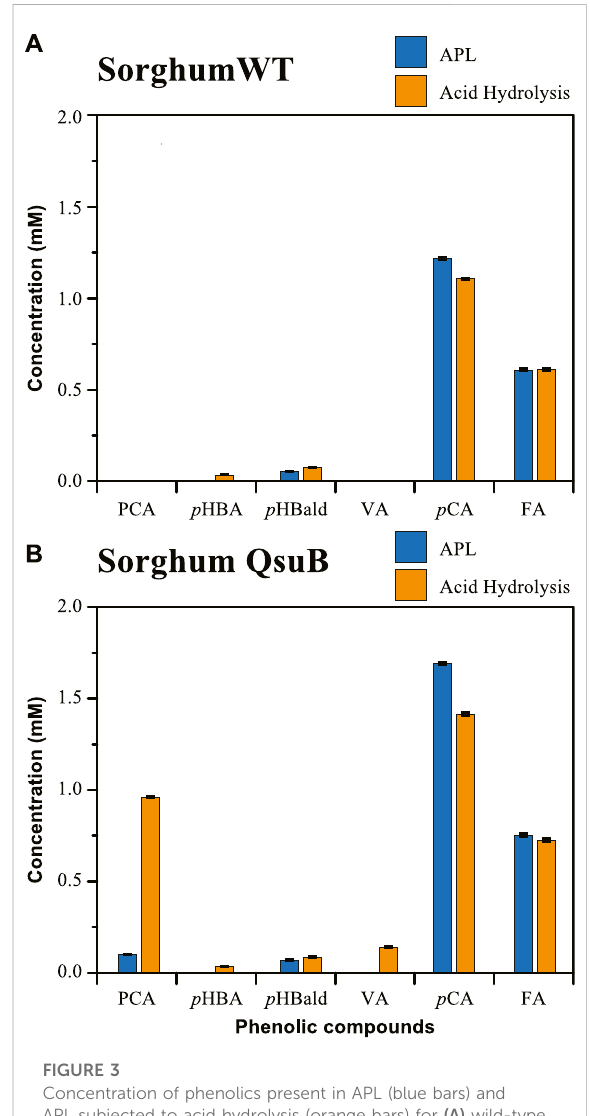
FIGURE 3 Concentration of phenolics present in APL (blue bars) and APL subjected to acid hydrolysis (orange bars) for (A) wild-type sorghum, and (B) QsuB sorghum. Abbreviations: protocatechuic acid (PCA), p -hydroxybenzoic acid ( p HBA), p -hydroxybenzaldehyde ( p HBald), vanillic acid (VA), p -coumaric acid ( p CA), ferulic acid